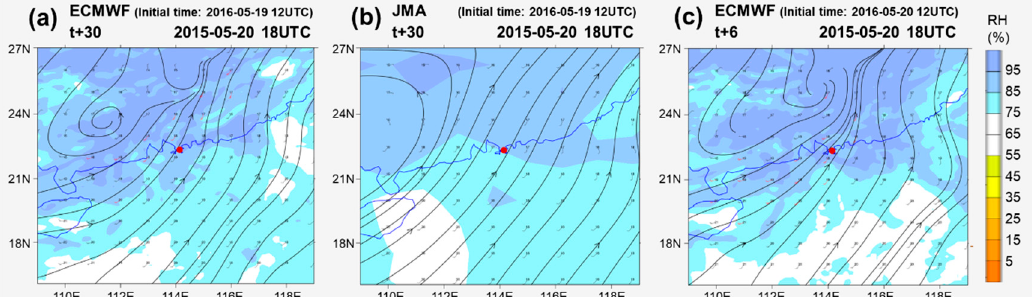
Figure 20. ( a , b ) The predicted 850 hPa moisture and wind fields of ( a ) ECMWF, ( b ) JMA for 20 May 2016 18 Z. ( c ) Ground truth of the same time based on ECMWF T + 6 h forecast. ECMWF indicated a deeper vortex over Guangdong and stronger southwesterly flow as a result of alignment of features.